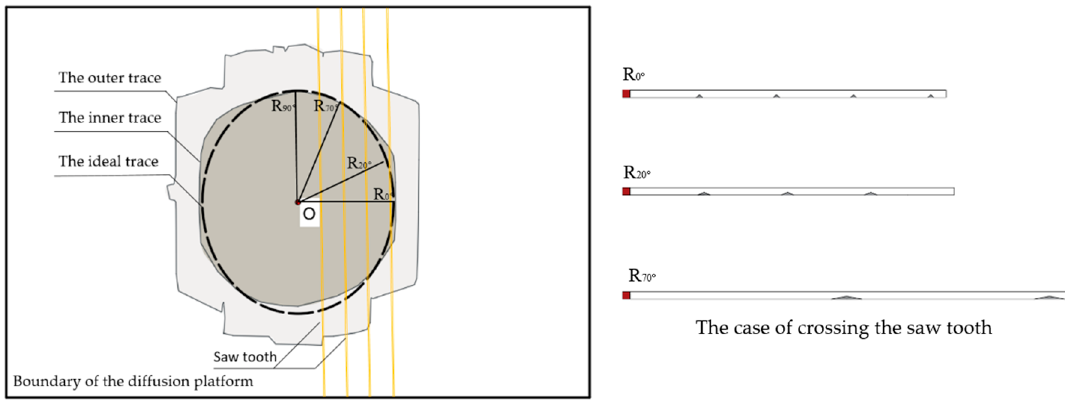
Figure 14. Schematic diagram of the anisotropic grouting diffusion theory.